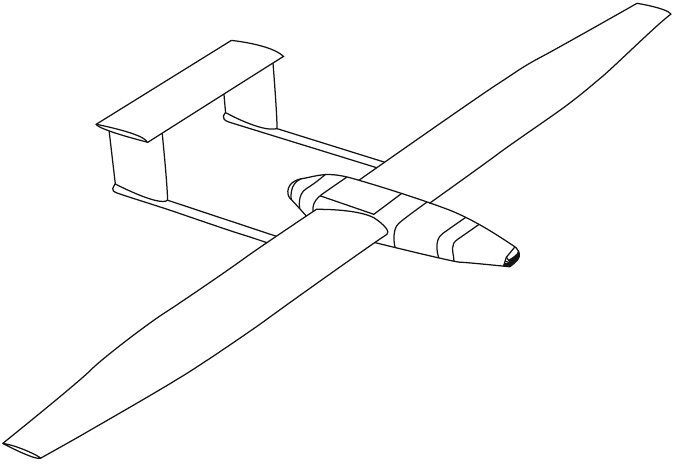
Figure 17: Final design of the UAV.